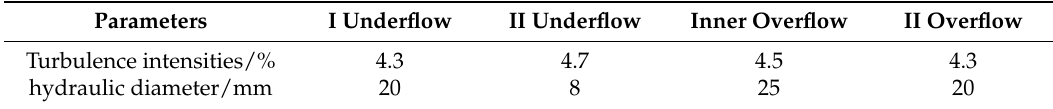
Table 1. Turbulence intensities and hydraulic diameters.